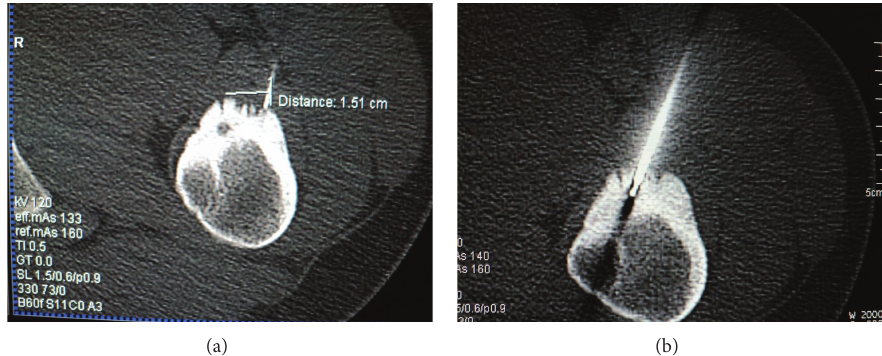
Figure 3: Spot CT images are obtained to confirm appropriate positioning.